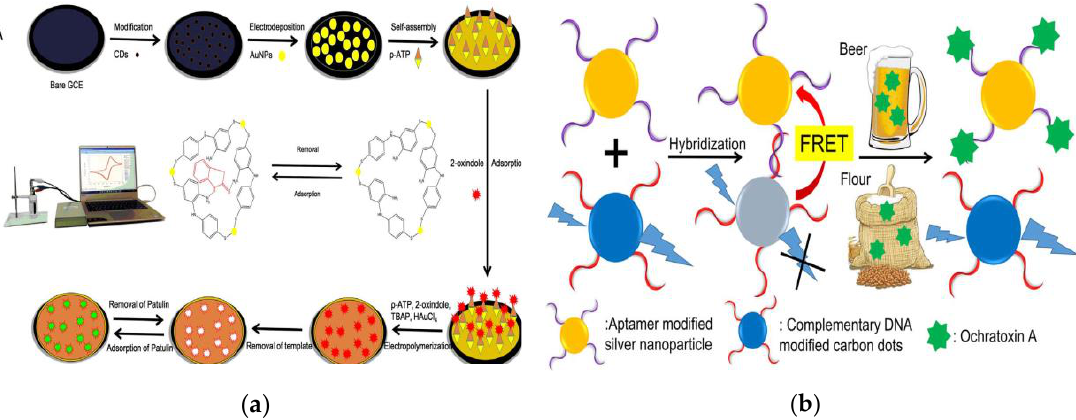
Figure 9. ( a ) Schematic of the preparation process of MIP-Au/CS-CQDs/GCE on glassy carbon electrode (GCE) and the detection of patulin. Reproduced with permission from [149]. Copyright Biosensors & Bioelectronics, 2017; ( b ) Schematic of fluorescent detection of ochratoxin A (OTA) in beer and flour based on FRET. Reproduced with permission from [153]. Copyright Talanta,